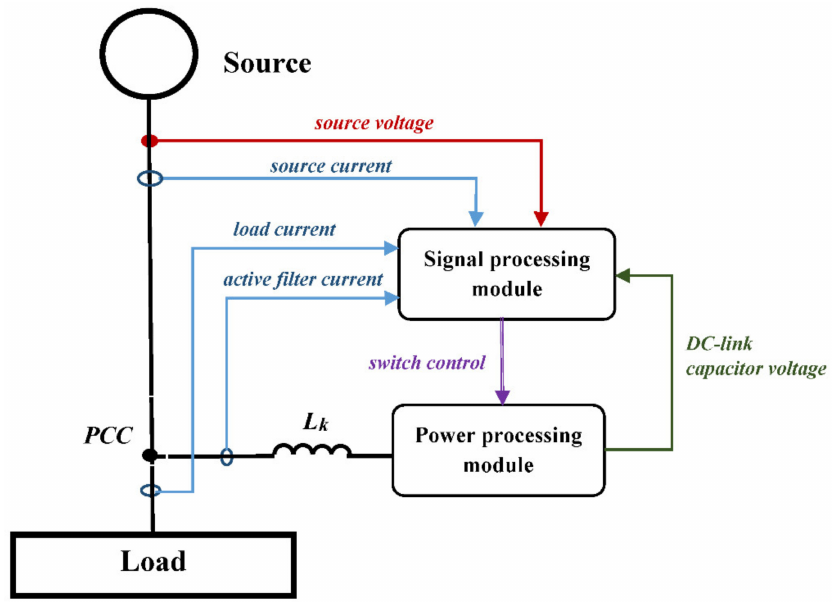
Figure 1. Source-line-load circuitry with active power filter block diagram. Active filter mod- ules and its signal tracks are shown in single-phase system conventionality. PCC is the point of common coupling.